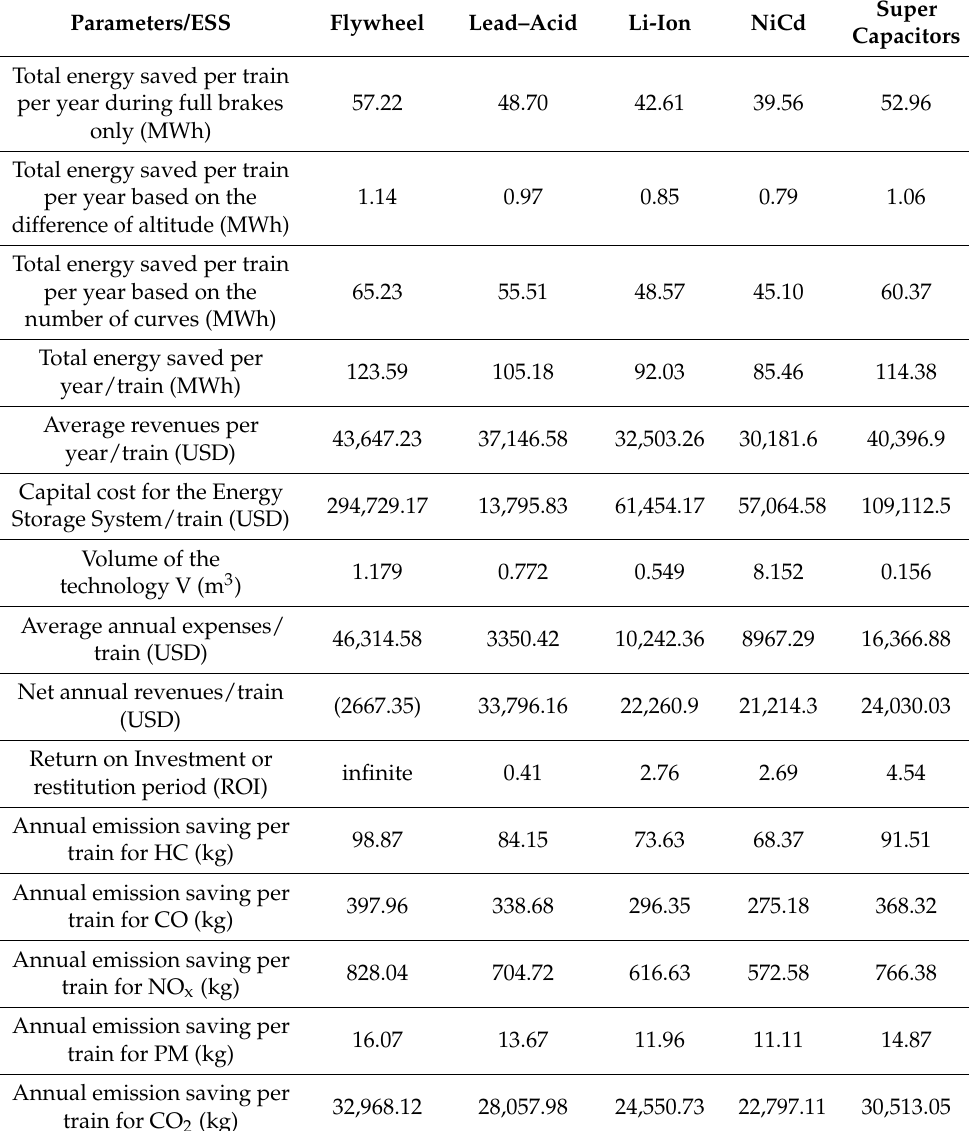
Table 6. Energetic, financial, and ecologic results for different ESS in the base case